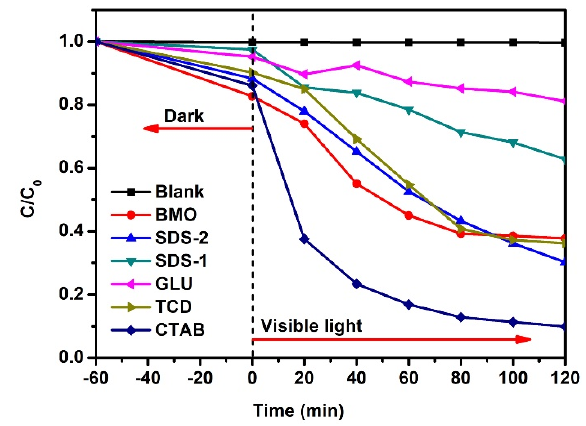
Figure 7. The photocatalytic activities for RhB over different samples under visible light